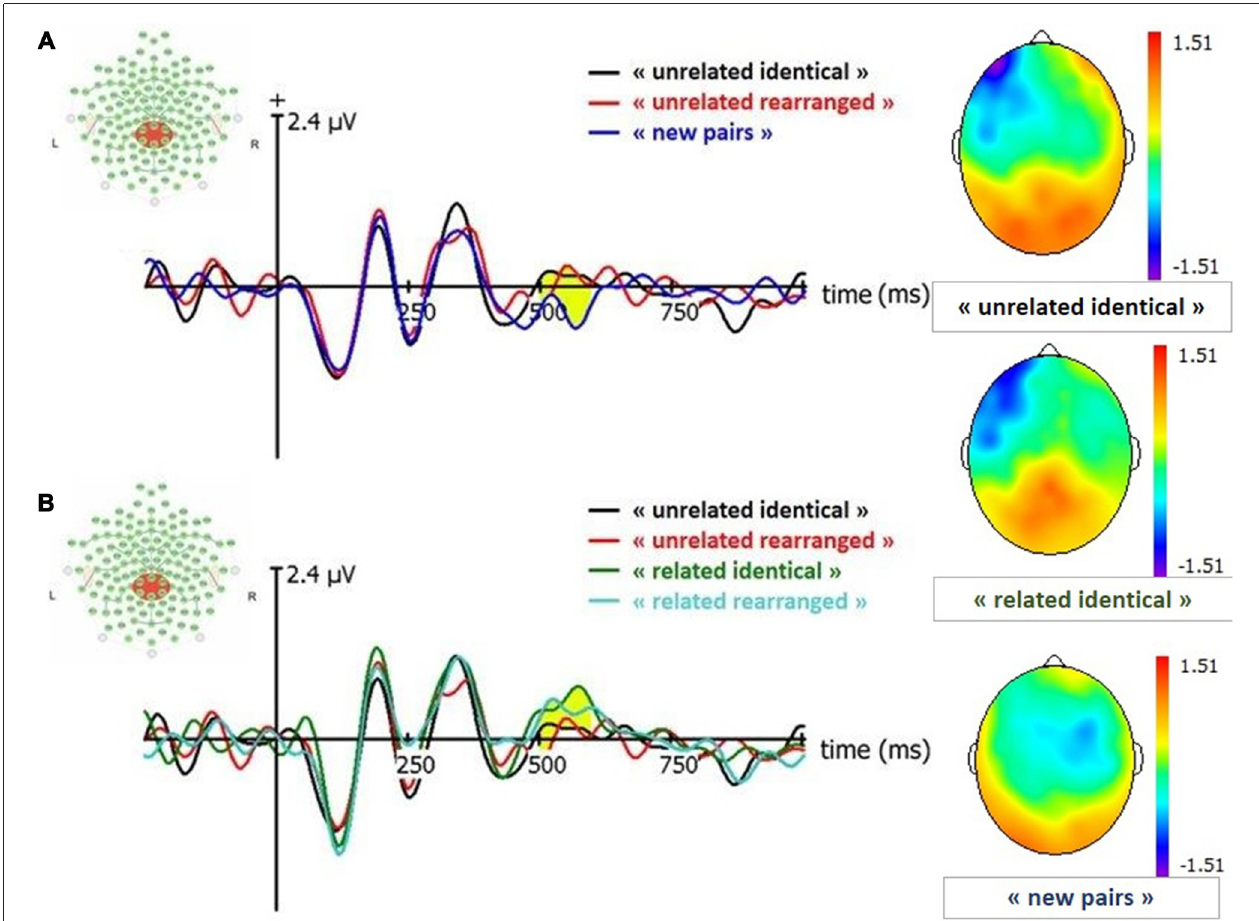
FIGURE 5 | ERP and topographies for Late Positive Component (LPC; signal in CPz between 500–600 ms). “related identical”: semantically related identical pairs; “related rearranged”: semantically related rearranged pairs; “unrelated identical”: semantically unrelated identical pairs; “unrelated rearranged”: semantically unrelated rearranged pairs; “new pairs”: semantically unrelated new pairs. (A) Old/New effect for unrelated pairs. (B) Effect of semantic factor on Condition. Yellow shaded areas correspond to significant differences between conditions.